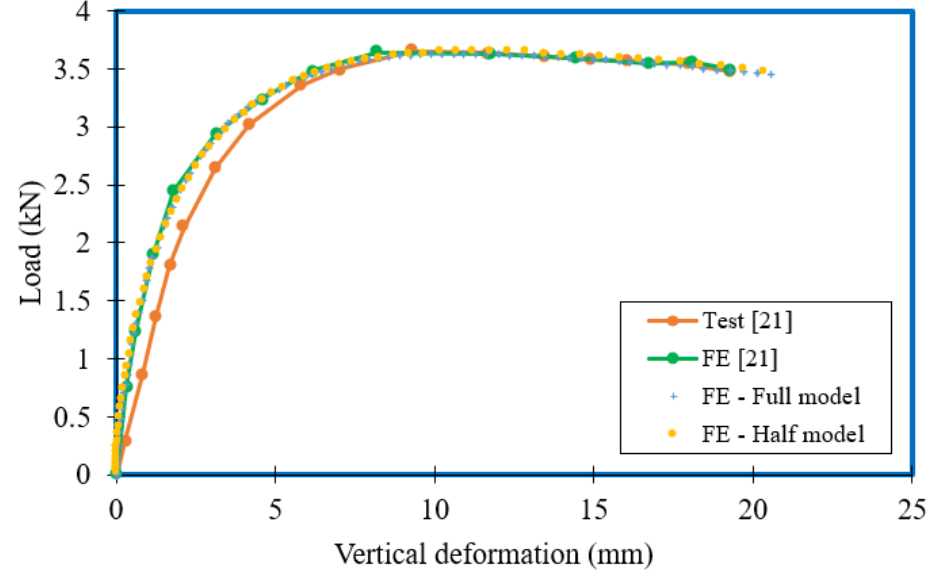
Figure 10. Load–vertical deformation comparison of ETF-UC20015 with 150 mm bearing plate [21].